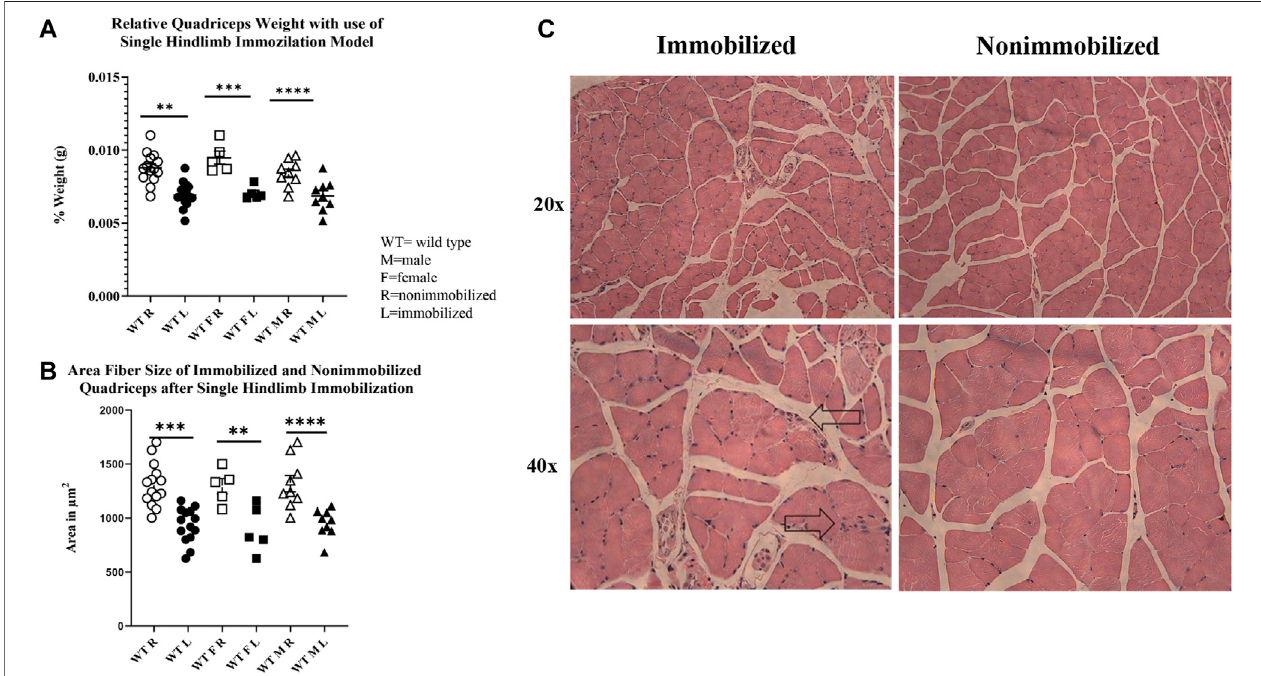
FIGURE 2 | Muscle atrophy induced by 2-week single hindlimb immobilization. (A) Relative weights of quadriceps normalized to the mouse body weights. Signi fi cantreductioninrelativequadricepsweightisseeninmale,female,andcombinedgroups. (B) Changein fi bersizeareaofimmobilizedquadriceps(L)comparedto nonimmobilized (R). Signi fi cant loss of fi ber size area is seen in both the males, females, and combined groups. (C) H&E images of immobilized and nonimmobilized quadriceps muscle are shown at both 20x and 40x objectives. Black arrows highlight potential immune cell in fi ltration as indicated by the multiple nuclei (n.s p